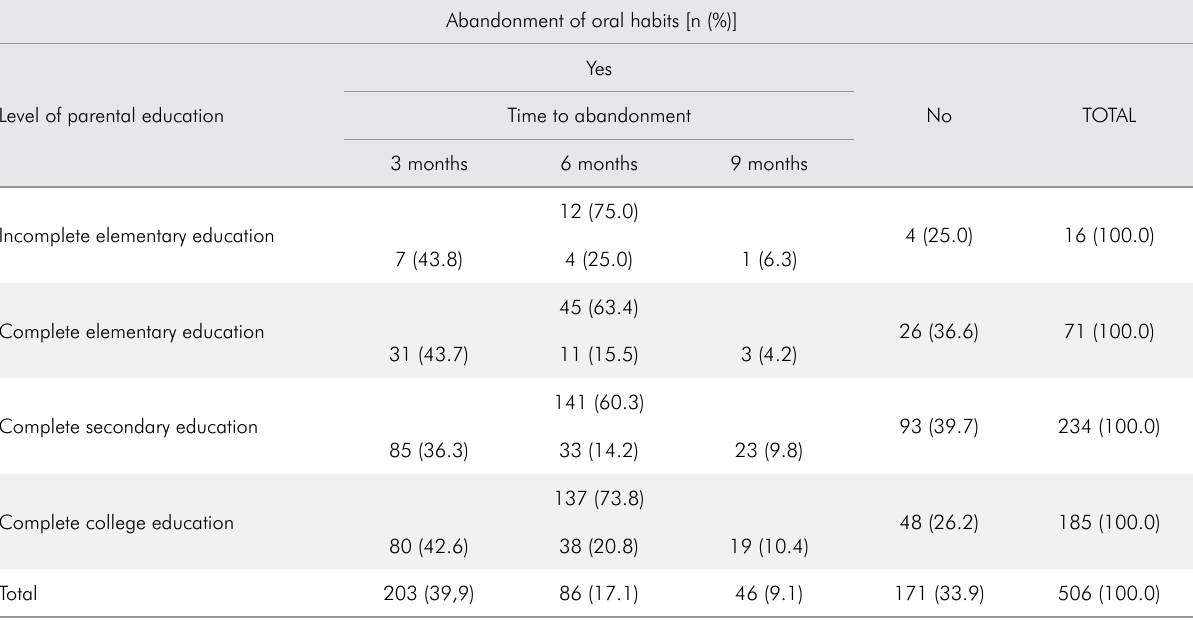
Table 5. Distribution of the level of parental education in relation to abandonment time of oral habits. Abandonment of oral habits [n